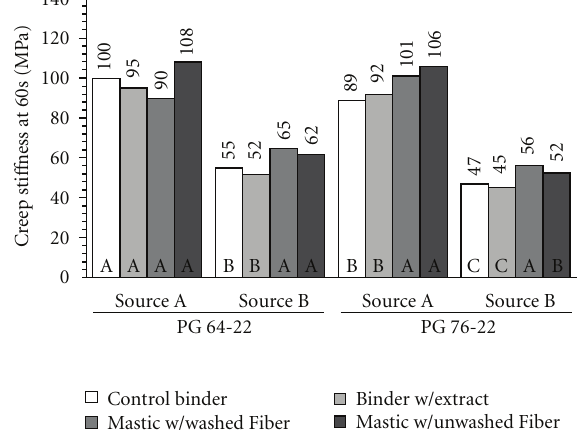
Figure 3: G ∗ / sin δ results from the dynamic shear rheometer (DSR). The test temperature was 64 ◦ C for the PG 64-22 binders and 76 ◦ C for the PG 76-22 binders.